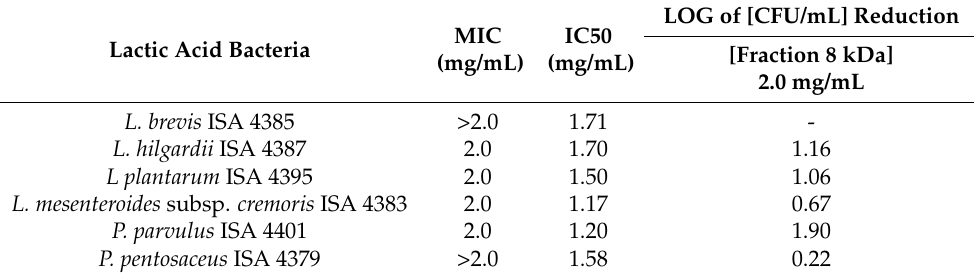
Table 4. Minimum inhibitory concentration (MIC), half-inhibitory concentration (IC50) and biocidal effect (Log of [CFU/mL] reduction) of fraction 8 kDa determined against six lactic acid bacte- ria